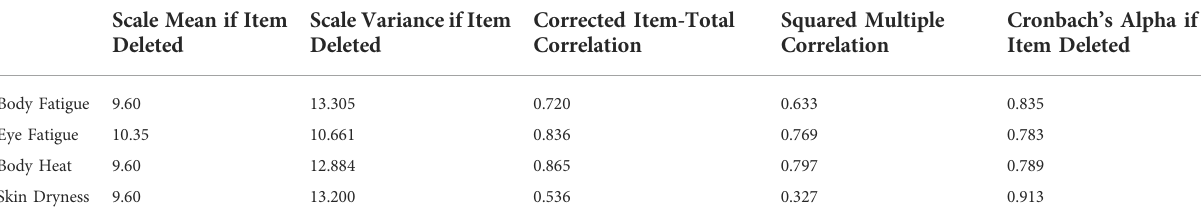
TABLE 6 Cronbach ’ s alpha: Item-total statistics.